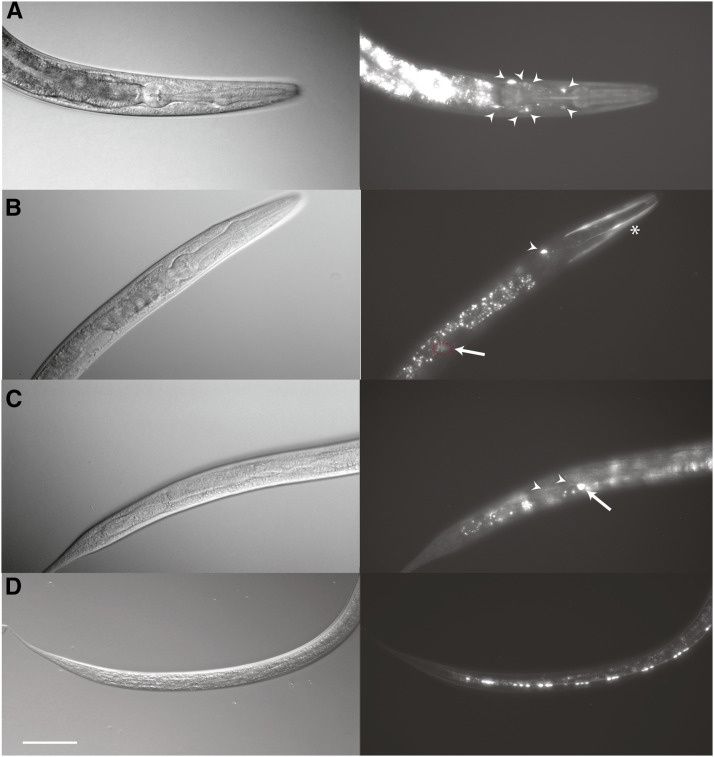
Postembryonic expression of Phlh-25::GFP. (A−D) Nomarski images (left) accompanied by green fluorescent protein fluorescent images (right). (A) Expression of cmjEx31 in multiple head neurons (arrowheads). This pattern was detected in animals at all stages, with a few additional neurons at dauer stage. (B) L3 expression in distal tip cell (arrow, red dashed circle), unidentified head neuron (arrowhead) and head muscles (asterisk). (C) L3 stage expression in PDE (arrow). Arrowheads indicate PDE processes. (D) Dauer stage expression in ventral nerve cord neurons. In all images anterior is to the right, dorsal is up. Scale bar represents 50 µm.